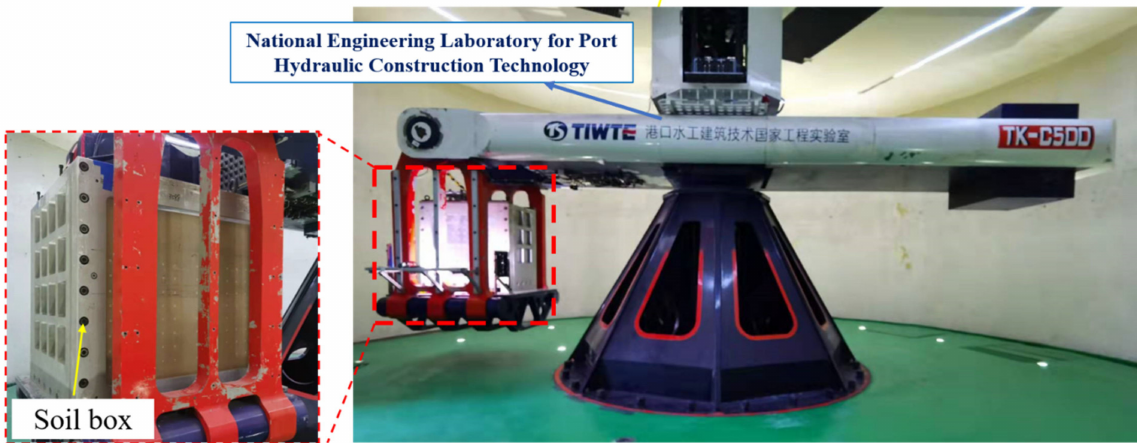
Figure 1. TK-C500 centrifuge.